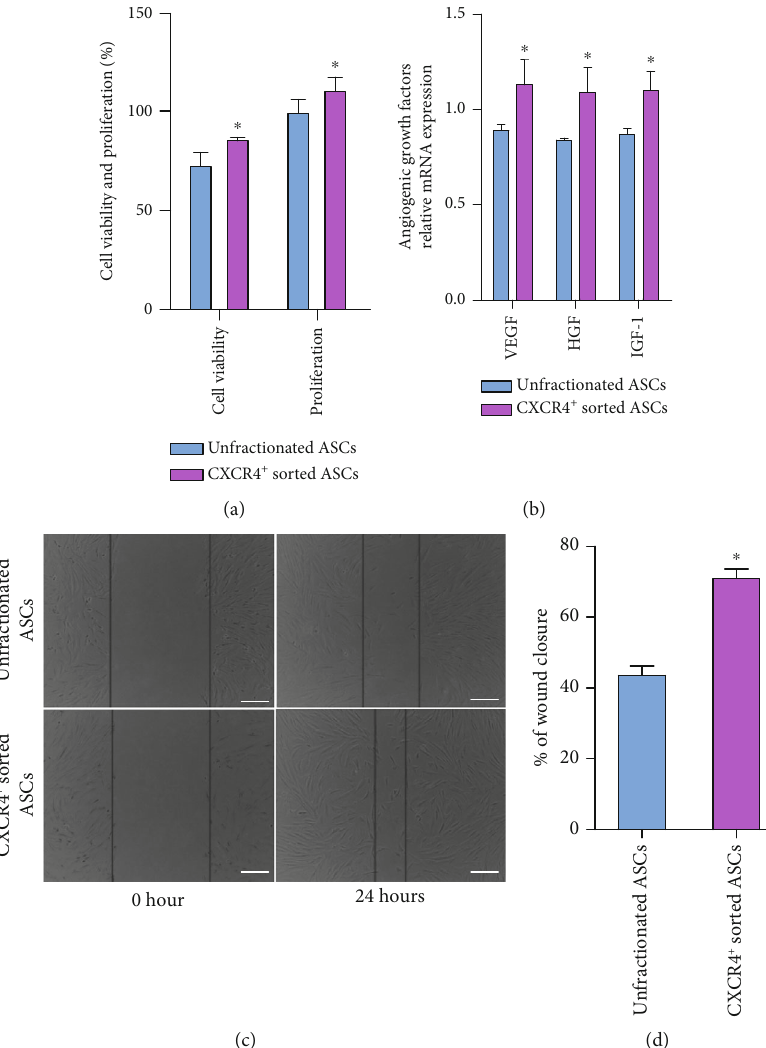
Figure 3: CXCR4 + sorted ASCs exhibited the better viability, proliferation, cytokine secretion, and migration than did unfractionated ASCs in vitro. (a) CXCR4 + sorted ASCs had markedly increased cell viability and proliferation rates compared with unfractionated ASCs. (b) CXCR4 + sorted ASCs secreted a higher level of angiogenic growth factors including VGEF, HGF, and IGF-1 relative to unfractionated ASCs. (c) Images were taken at 0 hour and 24 hours after scratch to visualize migrated cells and wound healing. (d) Scratch assay found a signi fi cantly higher wound closure percentage in CXCR4 + sorted ASCs than in unfractionated ASCs. Scale bar represents 200 μ m. ∗ p < : 05 versus unfractionated ASCs. Abbreviations: CXCR4: CXC-chemokine receptor 4; ASCs: adipose-derived stem cells; VEGF: vascular endothelial growth factor; HGF: hepatocyte growth factor; IGF-1: insulin-like growth